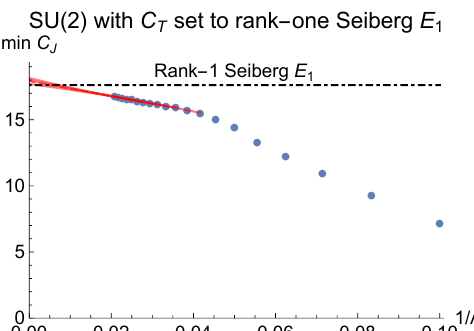
Figure 6. Lower bounds on C J with C T set to the value in the rank-one Seiberg E 1 theory, for interacting theories with SU(2) (cid:13)avor group, at various derivative orders (cid:3) and extrapolated to in(cid:12)nite order using the quadratic ansatz (5.21) (solid) and the linear ansatz (5.22) (dashed). Also shown is the value of C J in the rank-one Seiberg E 1 theory (dotdashed).